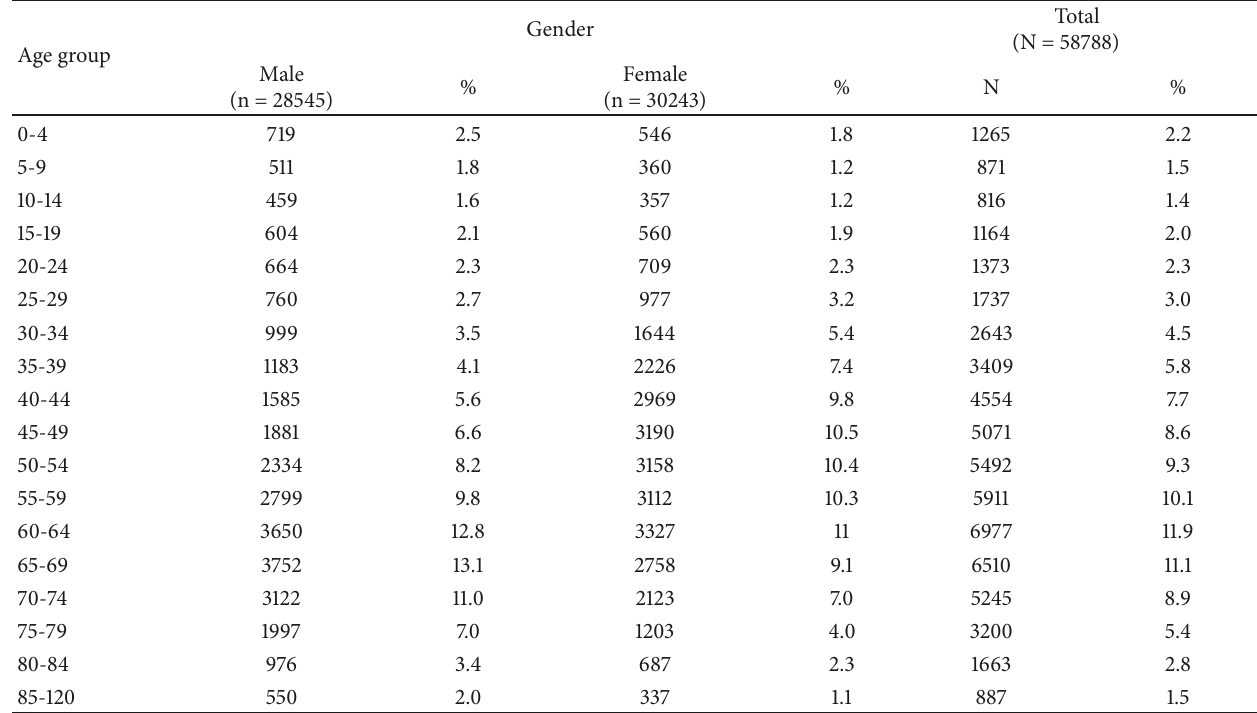
Table 1: The distribution of cumulative cancer cases registered in Jordan in the period 2000-2013 according to gender and age.